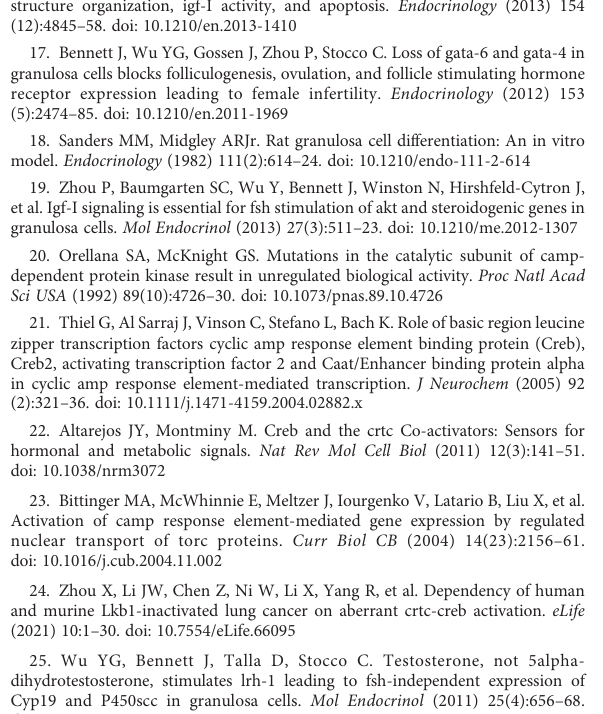
SUPPLEMENTARY FIGURE 1 caPKA and c2/CREB capacity to activate a CRE-reporter. HEK293 cells were transfected with pCRE-LUC plus empty vector, caPKA, or C2/CREB. Luciferase activity was determined 48 h after transfection. ** p<0.01 vs. empty, n = 3.